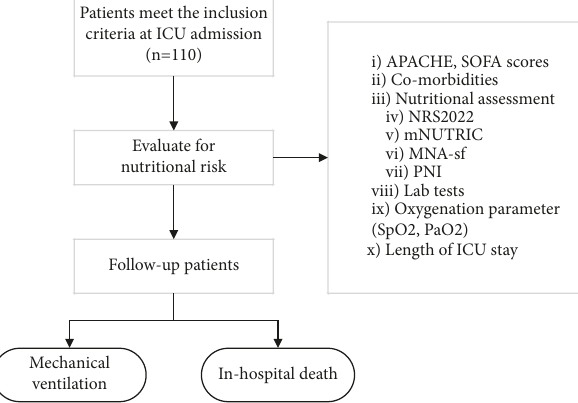
Figure 1: Flowchart of patients included in the